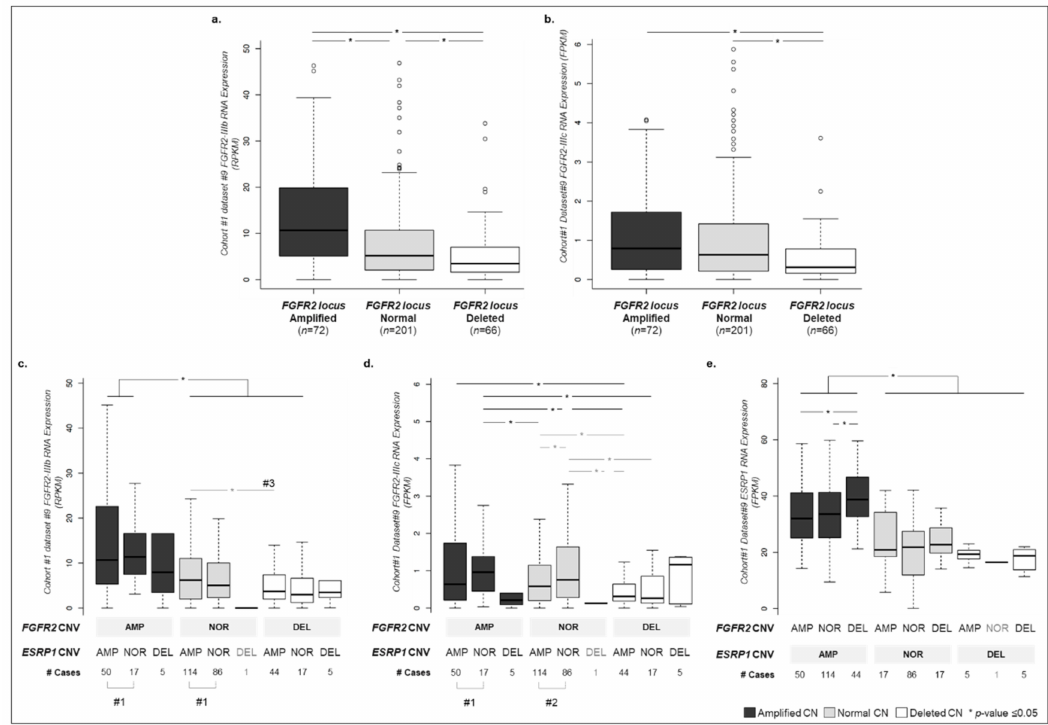
Figure 3. Copy number status of FGFR2 isoforms and ESRP1 and corresponding RNA expression level across GC cohort #1 dataset #9. ( a ) FGFR2-IIIb -specific exon RNA expression (RPKM) for GC cohort